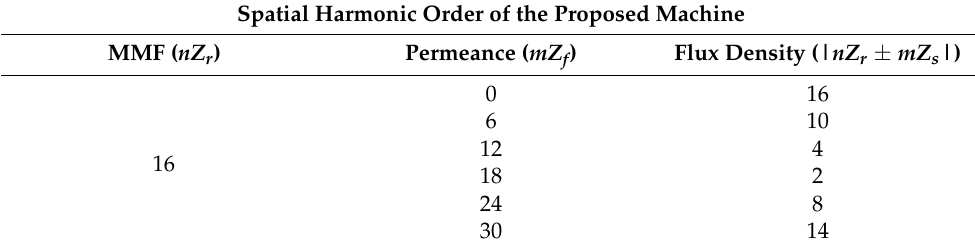
Table 2. The result ignores the higher harmonics of airgap permeance and MMF of mag- nets due to the lower amplitude. Compared with regular topology, the effect of non-uni- form tooth distribution is evident. In addition, the contents of harmonic caused by non- uniform tooth distribution will increase with the reducing of the unit number. Table 2. Summarization of Main Flux Density Harmonics. Table 2. Summarization of Main Flux Density Harmonics.